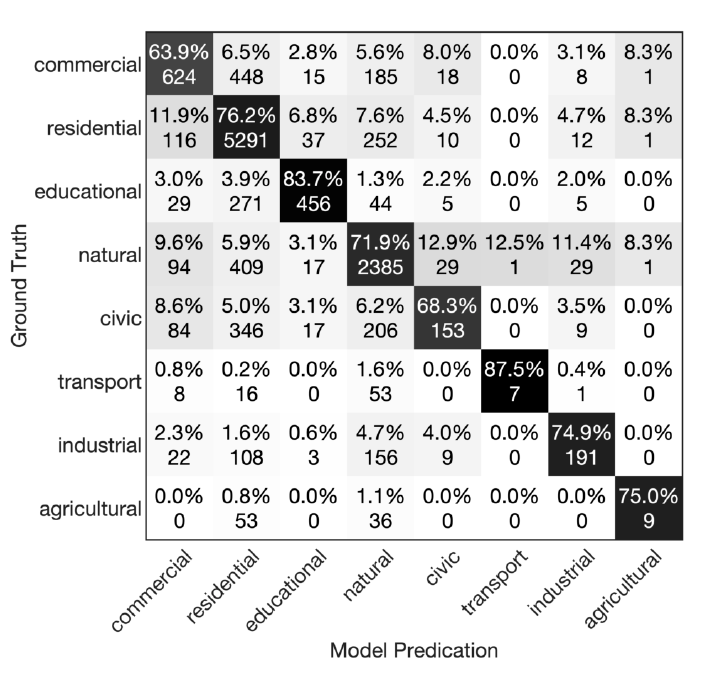
Figure 5. Classification accuracy of model prediction.